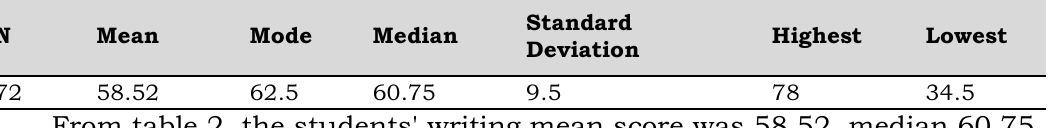
Table 2. The scores of students' writing taught using MALL